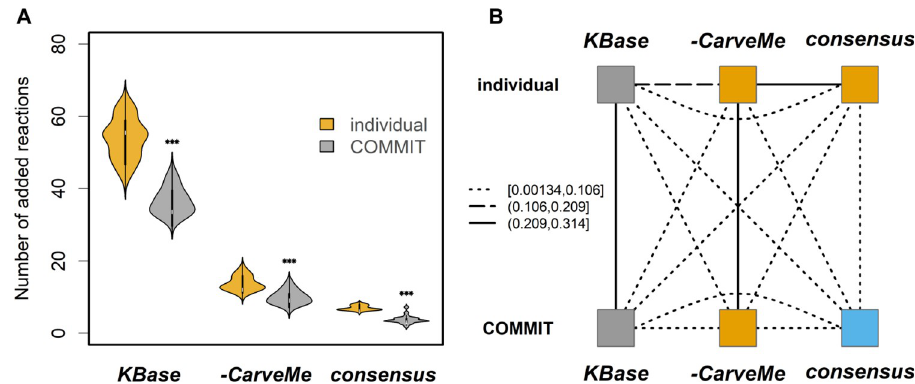
Fig 4. Comparison of gap filling solutions from COMMIT and individual models for the Schlaeppi community. Full consensus (consensus), consensus without CarveMe reconstructions (-CarveMe), and KBase draft reconstructions (KBase) were gap-filled either individually or using the COMM I T approach. (A) Sizes of gap-filling solution sets were compared for each reconstruction type using a paired Wilcoxon rank sum test ( ��� p < 0.001). (B) Pairwise comparison of added reactions obtained for each reconstruction and gap-filling type by calculating the Jaccard similarity per isolate. The resulting matrices were merged per group using the STATIS method [40–42]. The obtained values were grouped using K-means clustering (K = 3). The line types indicate the average similarity between the compared groups.